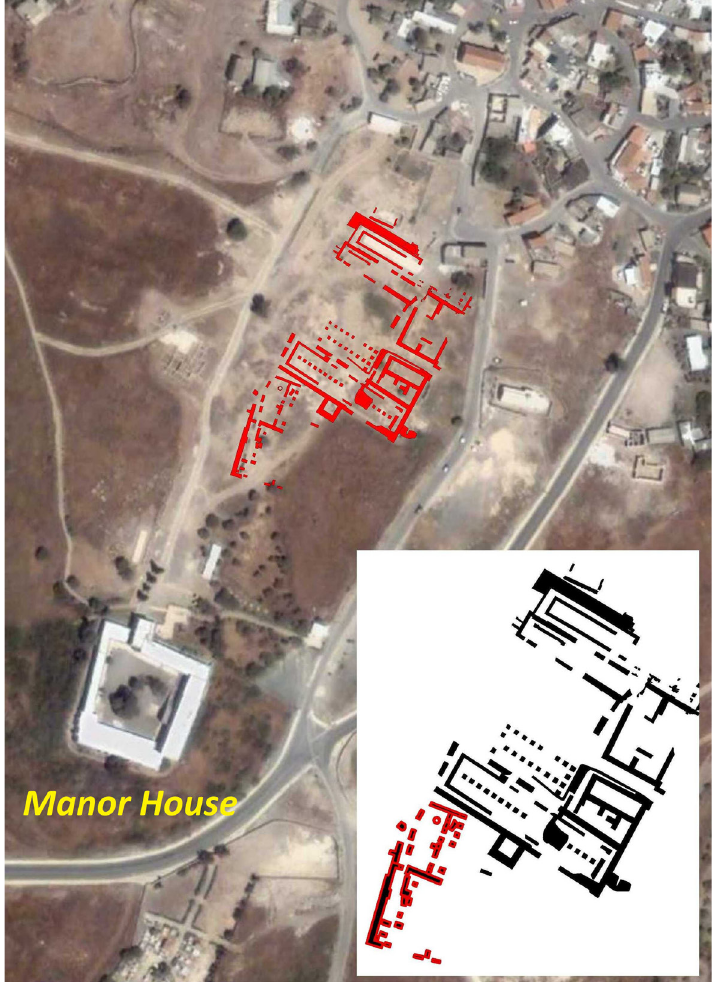
Figure 4. Ground plan of the ruins of the sanctuary with the Mediaeval Manor House to the south and the village of Kouklia to the north superimposed on Google Earth satellite image. A. Sarris and A. Agapiou (PULP@).